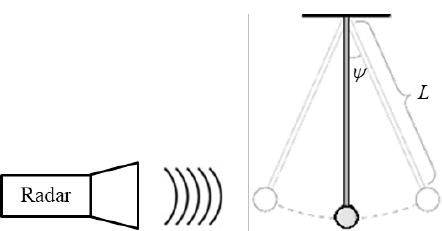
Figure 2. Illustration of the detection of a physical pendulum